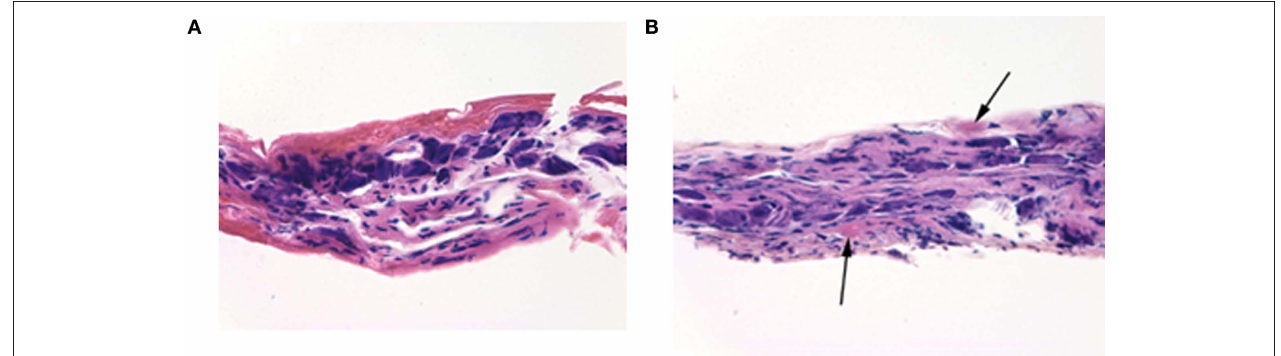
Figure 6 | Hematoxylin and eosin stain of postganglionic bladder nerves removed 48 h following implantation of the recording electrode. (A) The section of the control nerve not affected by surgery. No inflammatory cells were